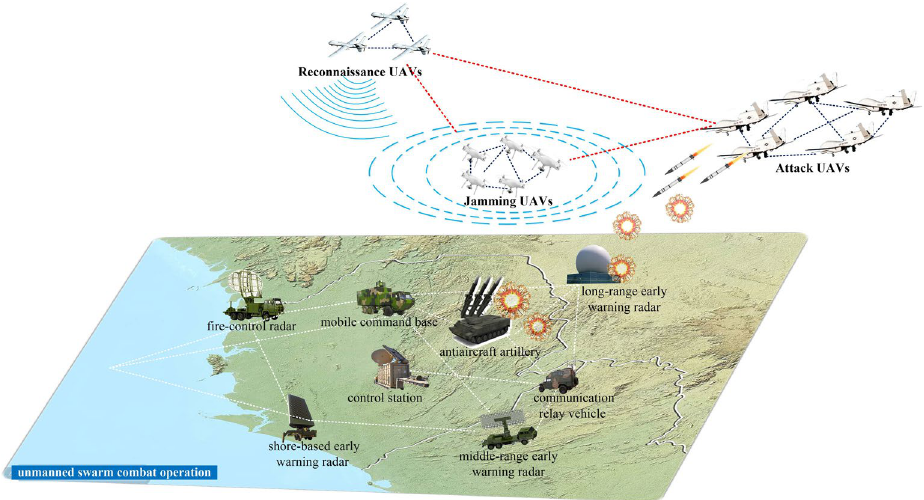
Figure 3. Sketch diagram of unmanned swarms attacking a ground